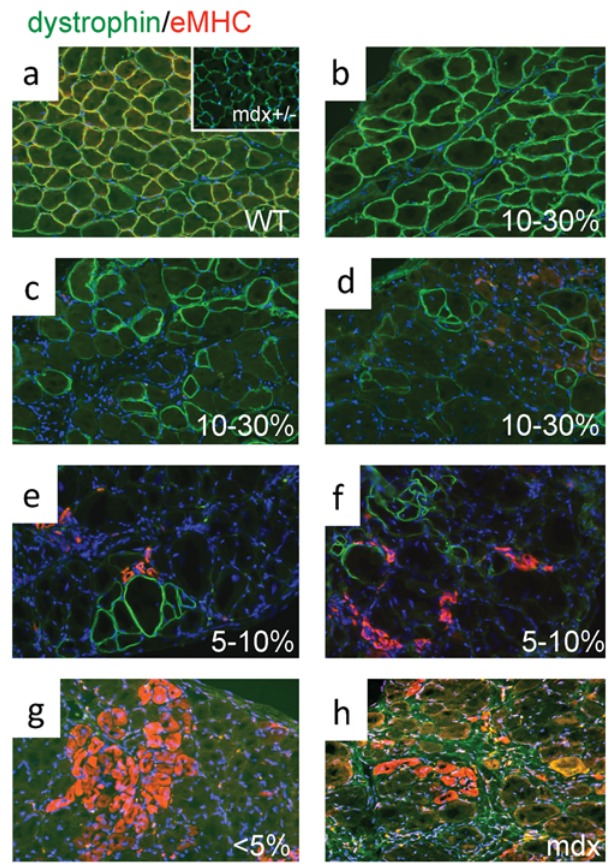
Figure 4. Embryonic MHC (eMHC) is greatly reduced in the skeletal muscle of R26 WT/mdx chimeras. a–d, diaphragms from WT (a), mdx + / 2 (a, inset), 10–30% WT/mdx (b–d), 5–10% WT/mdx (e, f), , 5% WT/mdx (g) and mdx (h) mice were sectioned and stained for dystrophin (green) and eMHC (red). b–d, areas with high (b) and low (c, d) numbers of dystrophin-positive fibers within the same WT/mdx diaphragm. e, f, all areas within the 5–10% WT/mdx diaphragm display low numbers of dystrophin-positive fibers. DAPI (blue) demarcates nuclei. Magnification: 200 6 . eMHC detection experiments were performed with pectoralis, diaphragm and quadriceps muscles of 2–4 animals per group (WT [n=4], mdx + / 2 [n=2], 10–30% WT/mdx [n=4], 5–10% WT/mdx [n=2], , 5% WT/mdx [n=4] and mdx